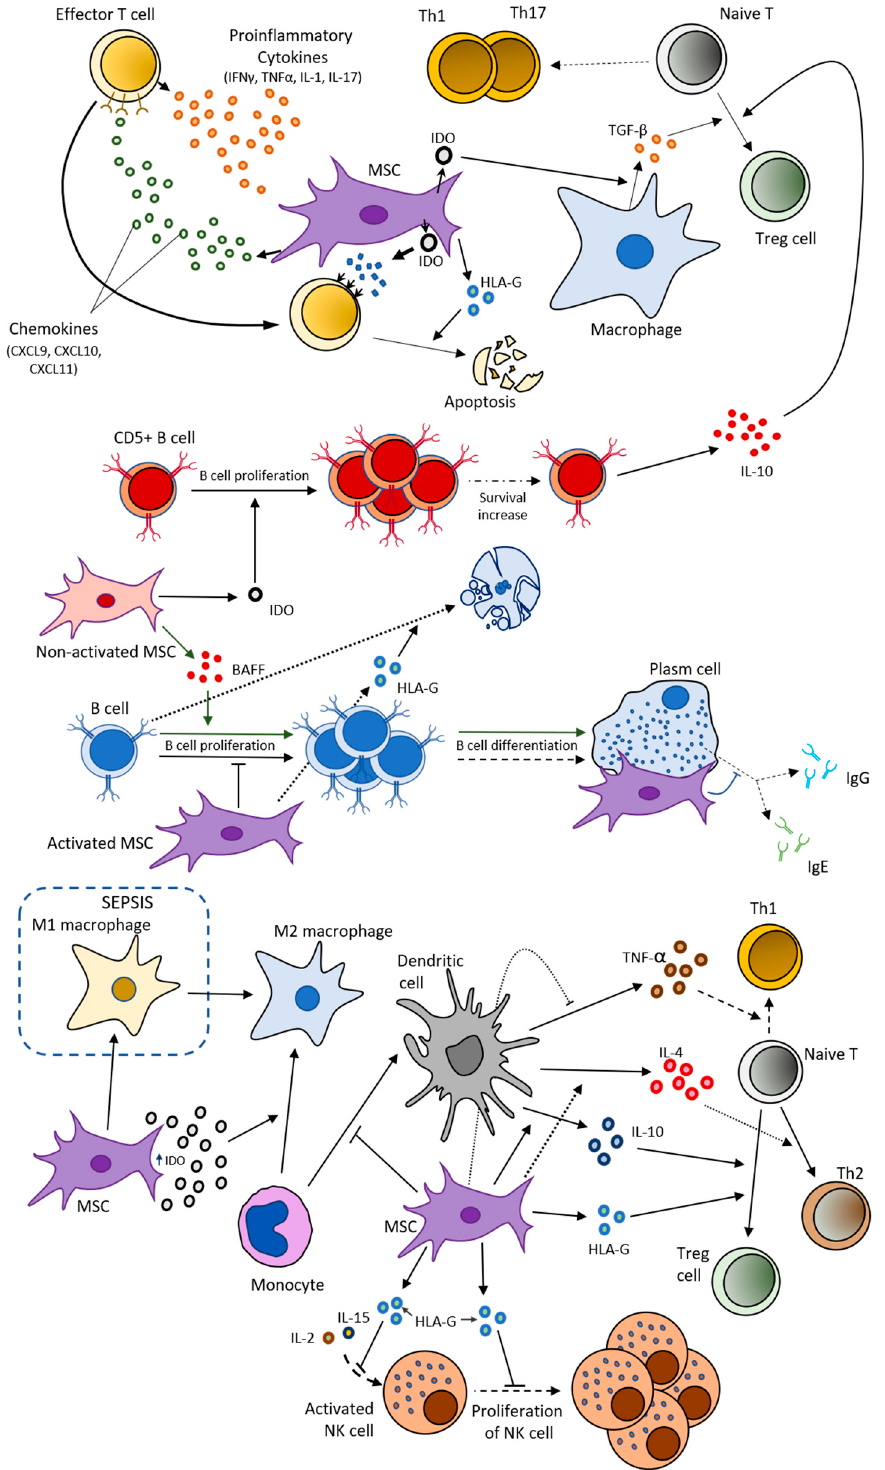
Figure 3. Immune interactions (immunomodulation) of mesenchymal stromal cells (MSCs). MSCs have been proven to have influence over both adaptative cells, such as T and B cells, and innate immune cells, such as dendritic cells, natural killer (NK) cells, monocytes, and macrophages by secreting several molecular factors as indoleamine 2,3-dioxygenase (IDO) and different cytokines. BAFF: B cell activating factor.